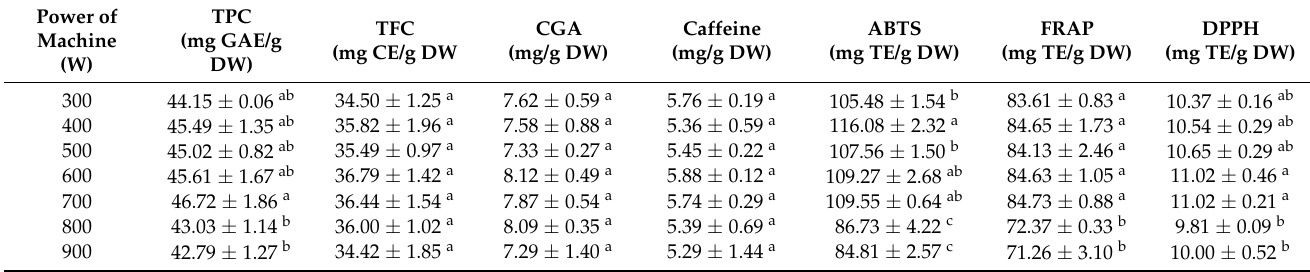
Table 5. Effect of radiation power on recovery of bioactive compounds and antioxidant from coffee